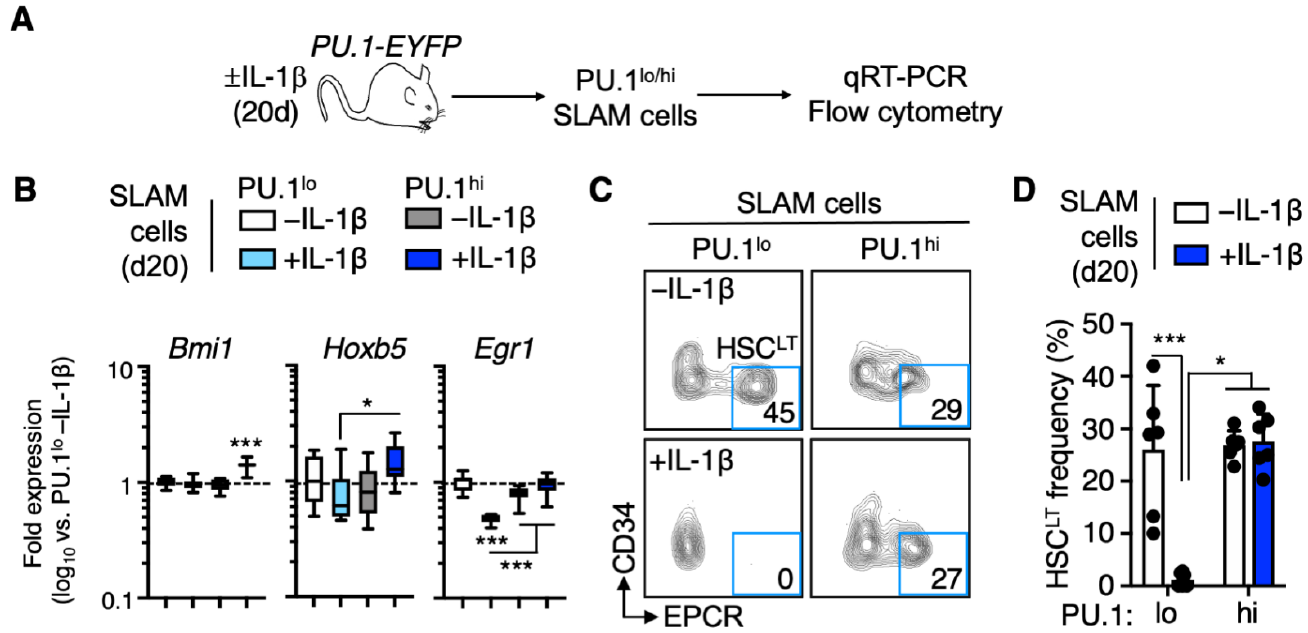
Figure 2. EPCR + HSCLT are depleted from the PU.1 lo SLAM fraction following IL-1 β treatment. ( A ) Experimental design for analysis of SLAM cells from PU.1-EYFP mice treated for 20 d IL-1 β . ( B ) Fluidigm qRT-PCR analysis of HSC genes in PU.1 lo and PU.1 hi SLAM cells from PU.1-EYFP mice treated for 20 d IL-1 β ( n = 8/grp). Data are expressed as log10 fold change versus PU.1 lo -IL-1 β . Box represents upper and lower quartiles, with line representing median value. Whiskers represent minimum and maximum values. Data are representative of two independent experiments. ( C ) Representative FACS plot showing phenotypic HSCLT frequencies within the SLAM gate in PU.1-EYFP mice treated for 20 d IL-1 β . ( D ) Summary data showing phenotypic HSCLT frequency within the SLAM gate of PU.1-EYFP mice treated for 20 d IL-1 β ( n = 6/grp). Individual values are shown, and bars represent mean values. Data are compiled from two independent experiments. Data are shown as means SD. Significance was determined by ANOVA with Tukey’s post-test. * p < 0.05; *** p < 0.001.